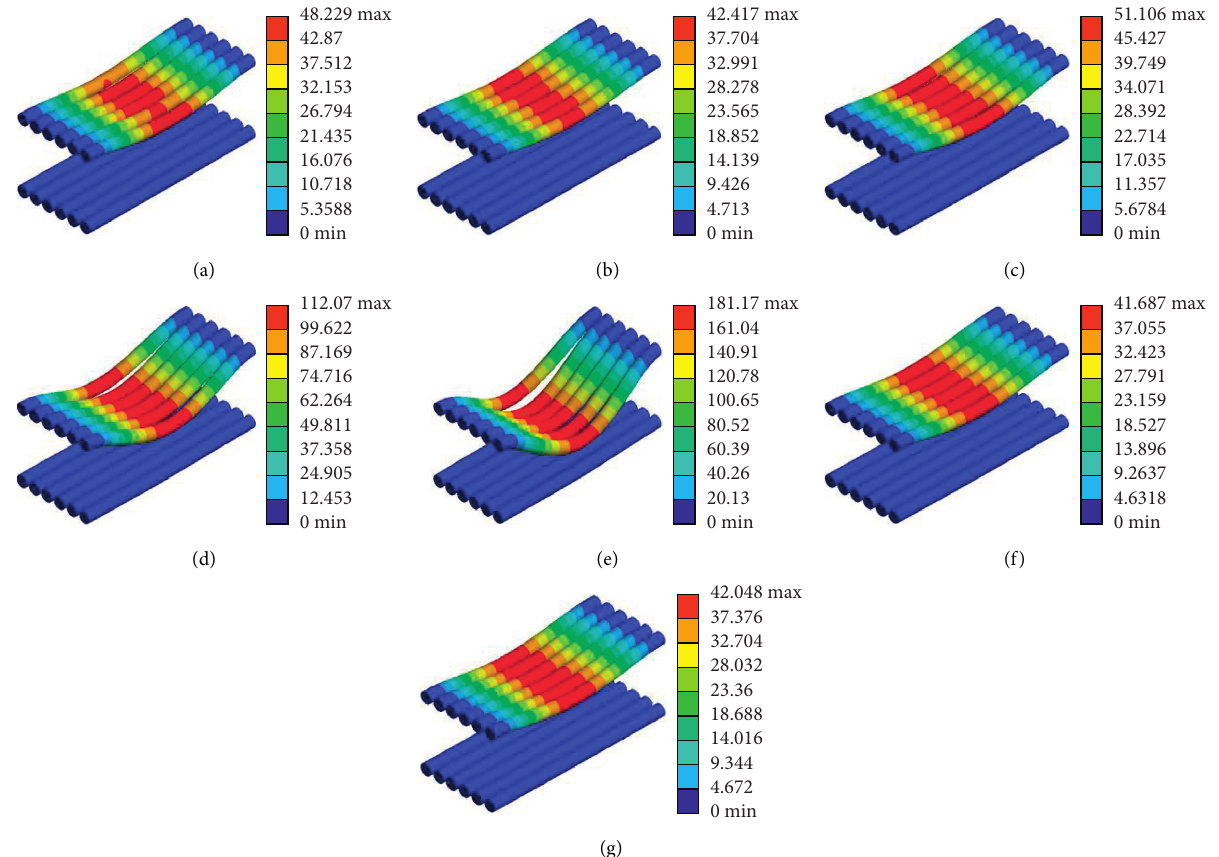
Figure 6: Fiber deformations under different process parameters. (a) ∼ (g) The numbers are consistent with Table 2. (a) No. 1. (b) No. 2. (c) No. 3. (d) No. 4. (e) No. 5. (f) No. 6. (g) No. 7. Table 3: Characteristic parameters under different AFP process parameters.